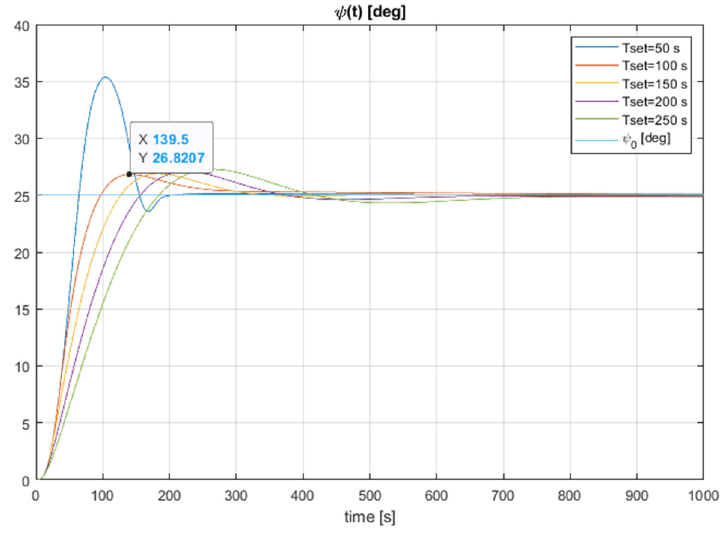
Figure 2. Static and dynamic behaviour of the ADRC system for different settling time parameter.